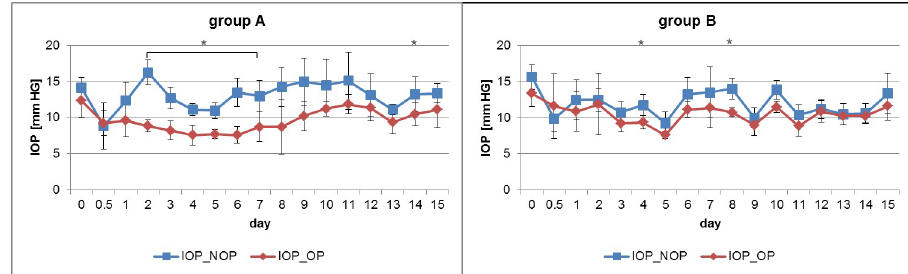
Fig 4. Temporal IOP course of the operated and control eye for groups A and B. The IOP is specified as the daily mean inclusive of the standard deviation (n = 4). The red graph represents the IOP of the operated eye (IOP_OP) and the blue one the IOP of the control eye (IOP_NOP). Day 0.0 marks the preoperative IOP and day 0.5 the postoperative IOP on the day of implantation. On the subsequent postoperative days, the mean IOP is also presented. Statistically significant differences (p � 0.05) between the IOP in the operated eye and the control eye are marked with an